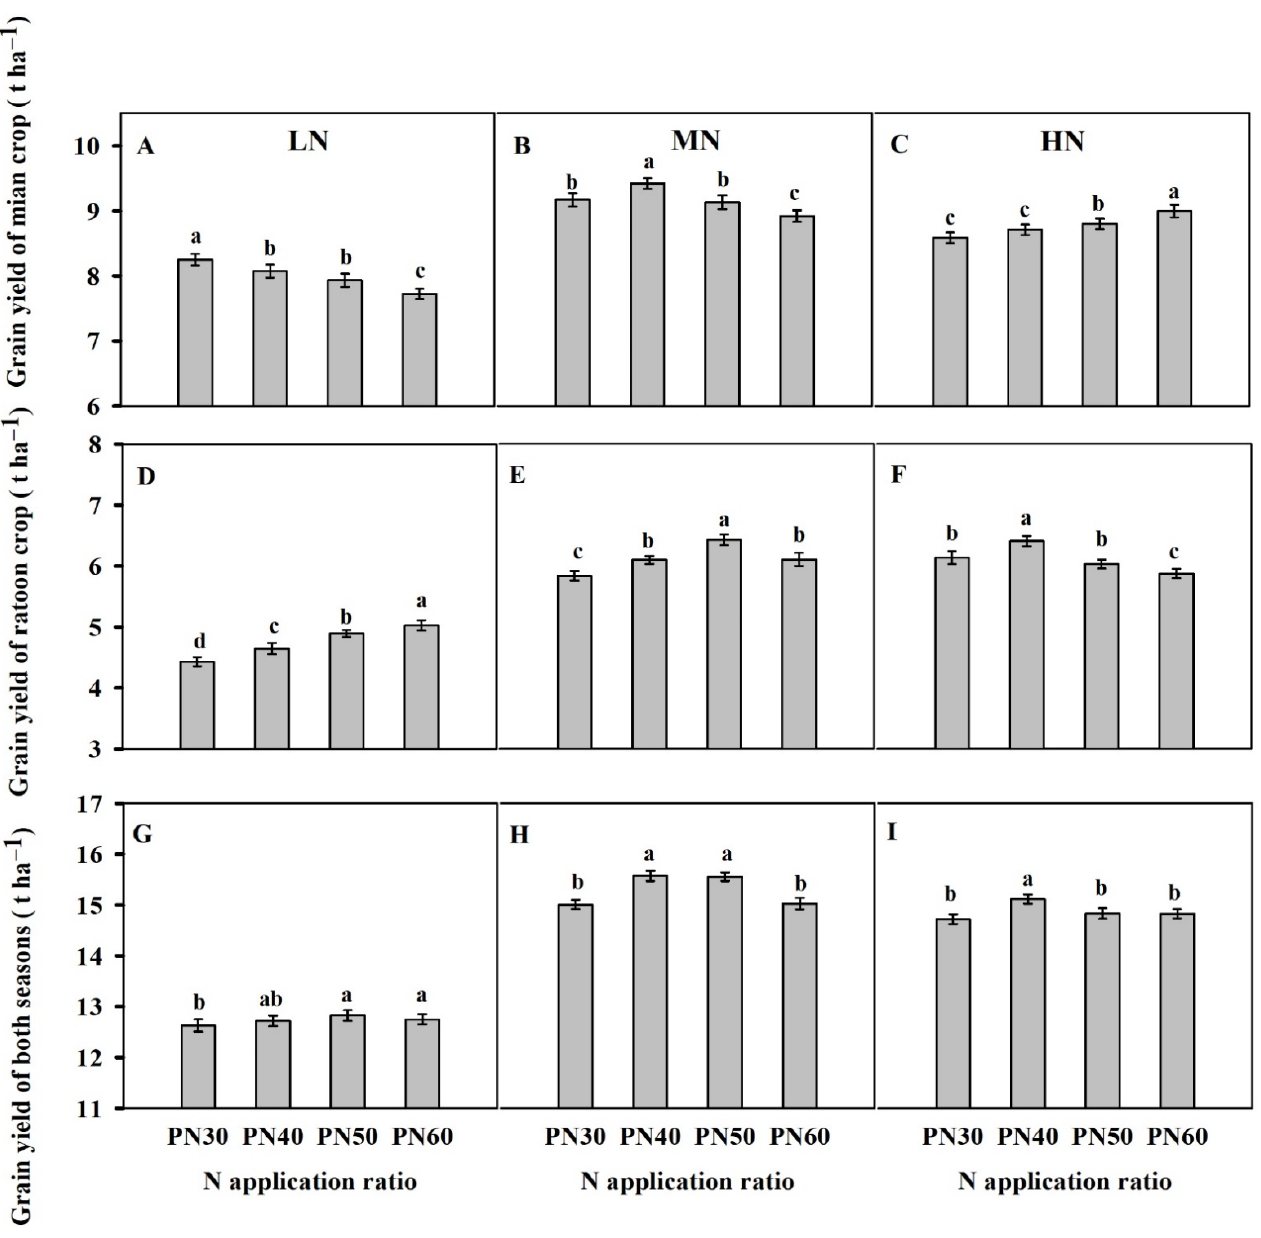
Figure 1. Effects of N regime in the main crop on the yield of the main crop ( A – C ), ratoon crop ( D – F ), and both seasons ( G – I ). Error bars are ±SE. Note: LN, low N rate (the total amount of N applied was 100 kg ha − 1 ); MN, medium N rate (the total amount of N applied was 250 kg ha − 1 ); HN, high N rate (the total amount of N applied was 400 kg ha − 1 ). PN30, PN40, PN50, and PN60 correspond to N application ratios of basal tillering fertilizer to panicle fertilizer of 7:3, 6:4, 5:5, and 4:6, respectively. The different lowercase letters at the same N application rate indicate significant differences at the 5% probability level according to LSD tests. Table 4. Effects of N regime in the main crop on the yield components of the ratoon crop.